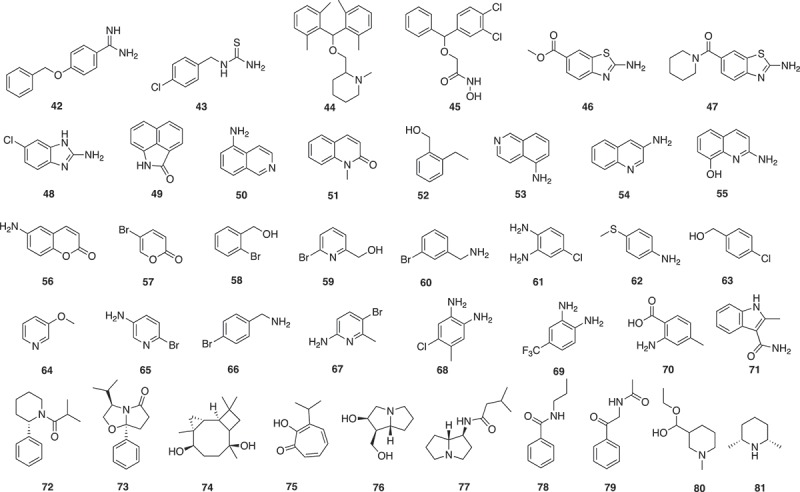
Fragment-based hits.